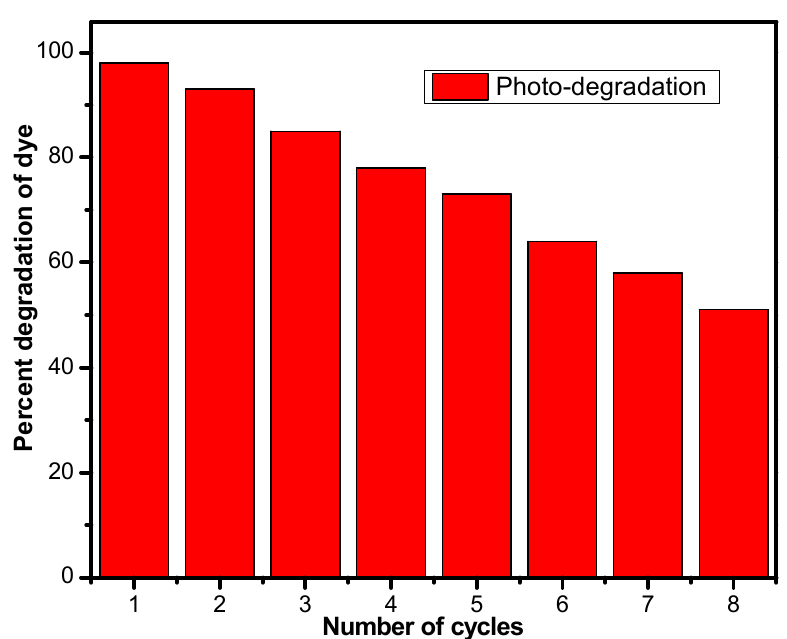
Figure 8. Recycled photocatalytic efficiencies of ZnWO 4 -NPs@rGO nanocomposites.